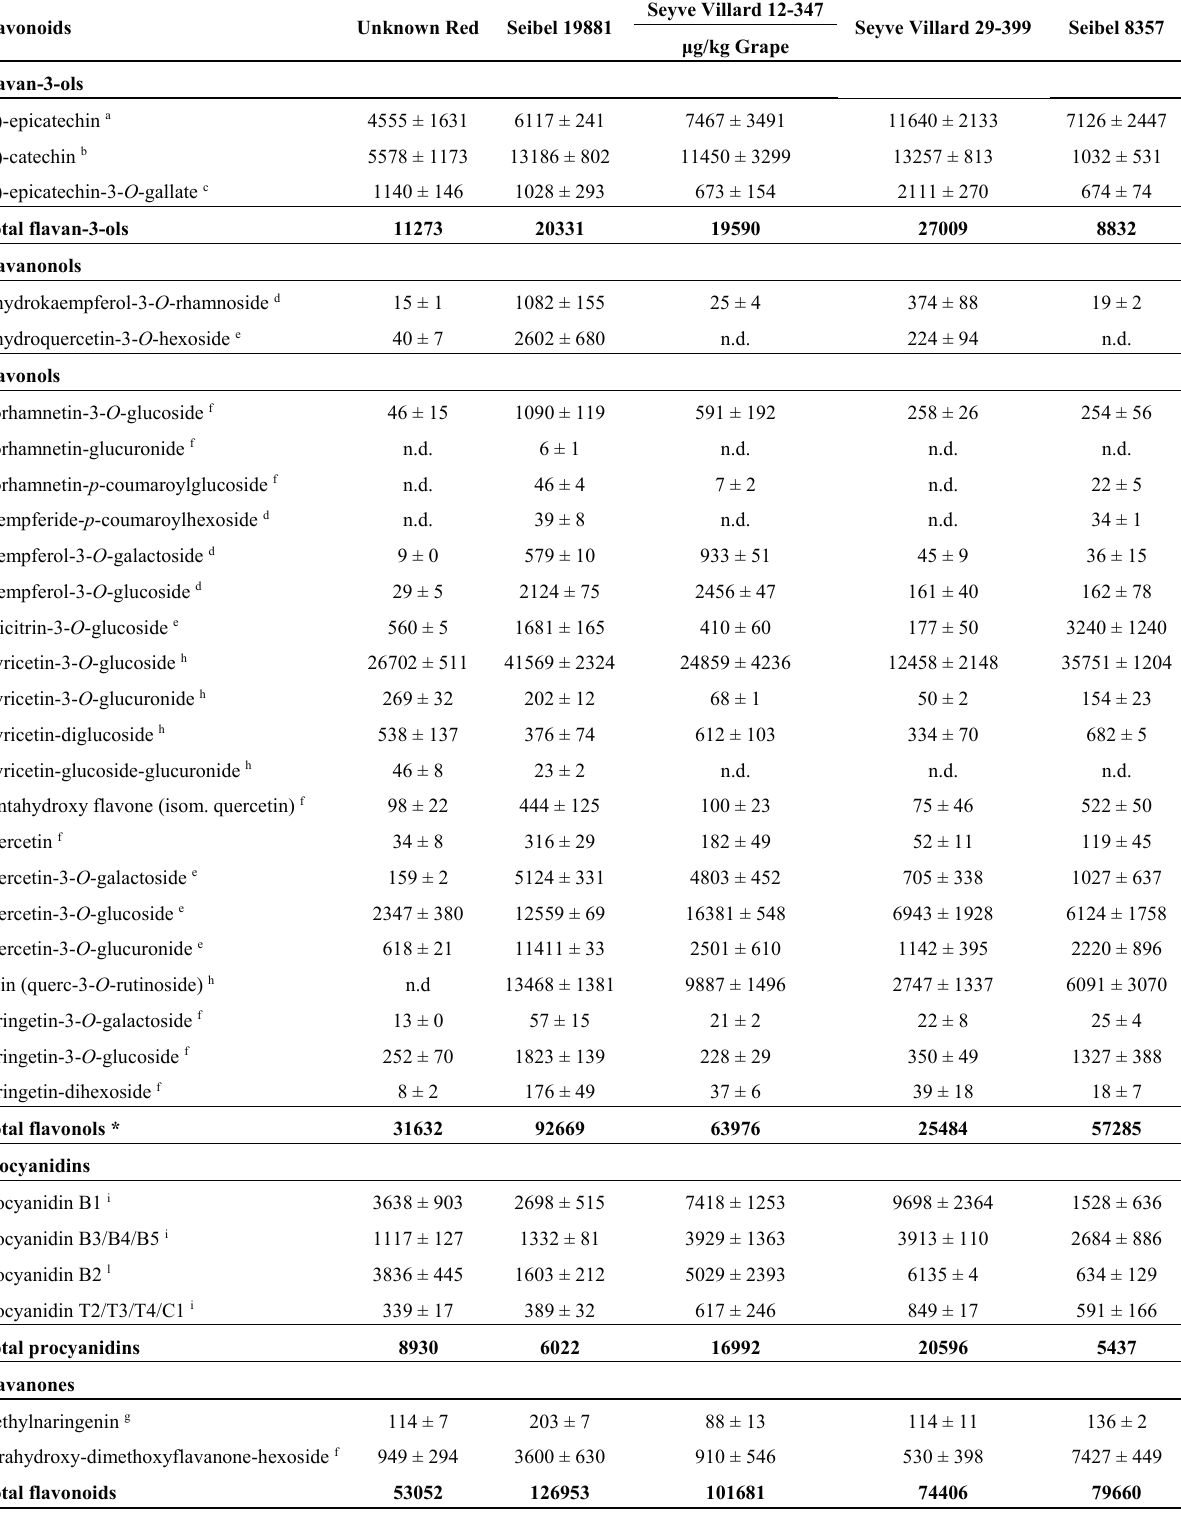
Table 2. Semi-quantitative contents of non-anthocyanic flavonoids identified in the samples. Mean data of four samples (harvests 2011 and 2012), are